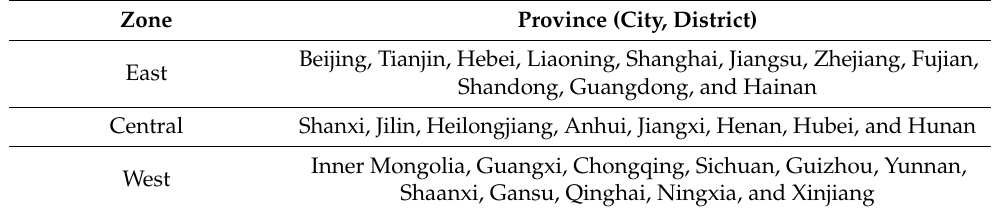
Table 10. Division of